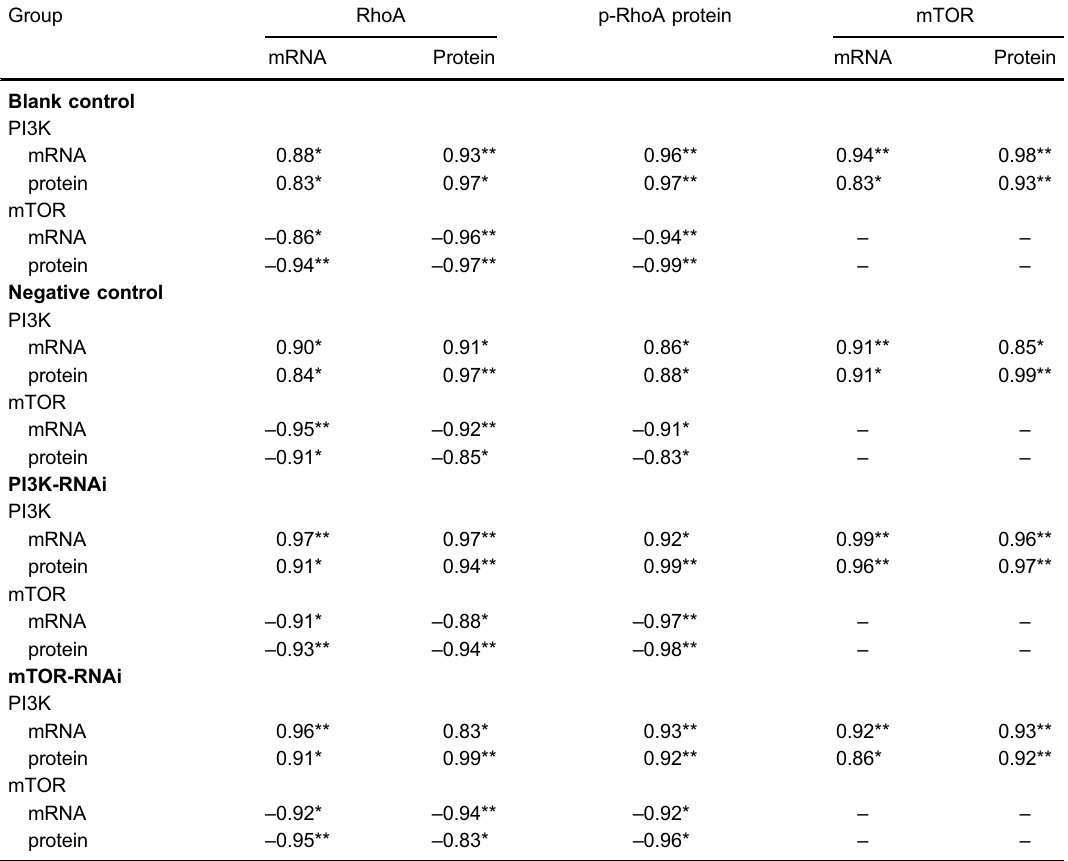
Table 3. Analysis of the correlation between PI3K, mTOR, and RhoA mRNA and proteins in each group (r